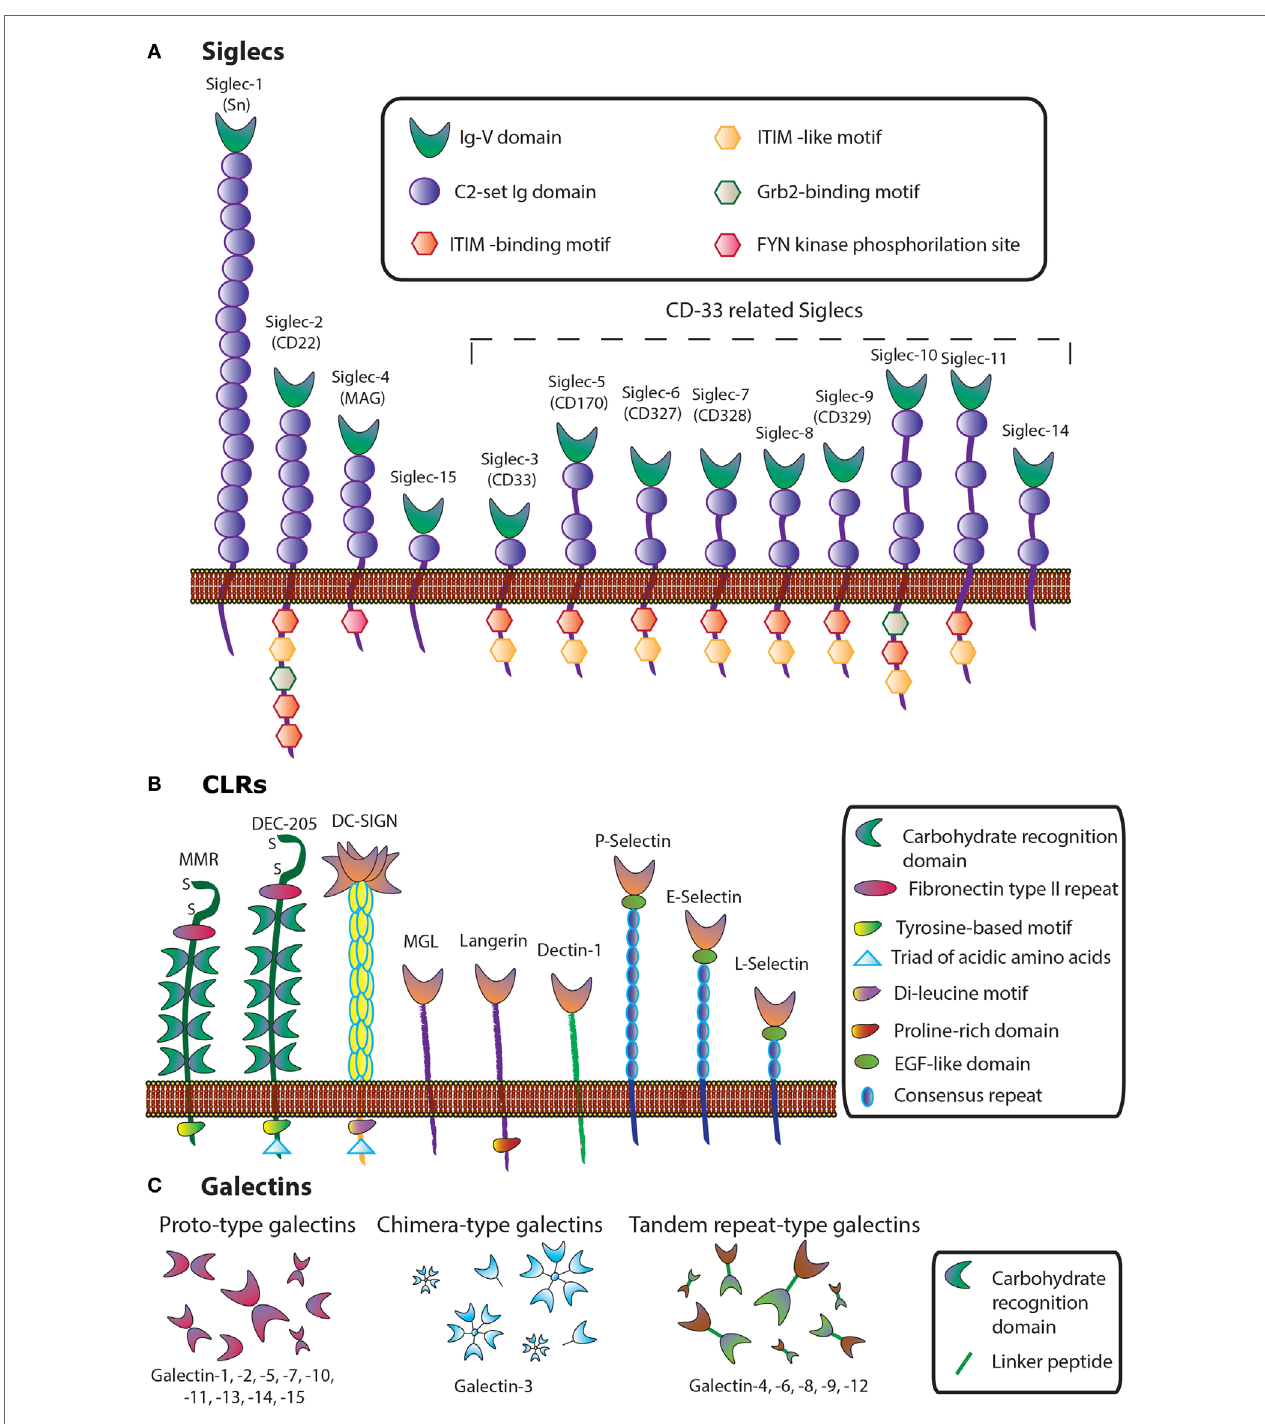
FiGURe 2 | Schematic representation of three lectin families: (A) siglecs, (B) C-type lectins, and (C) galectins